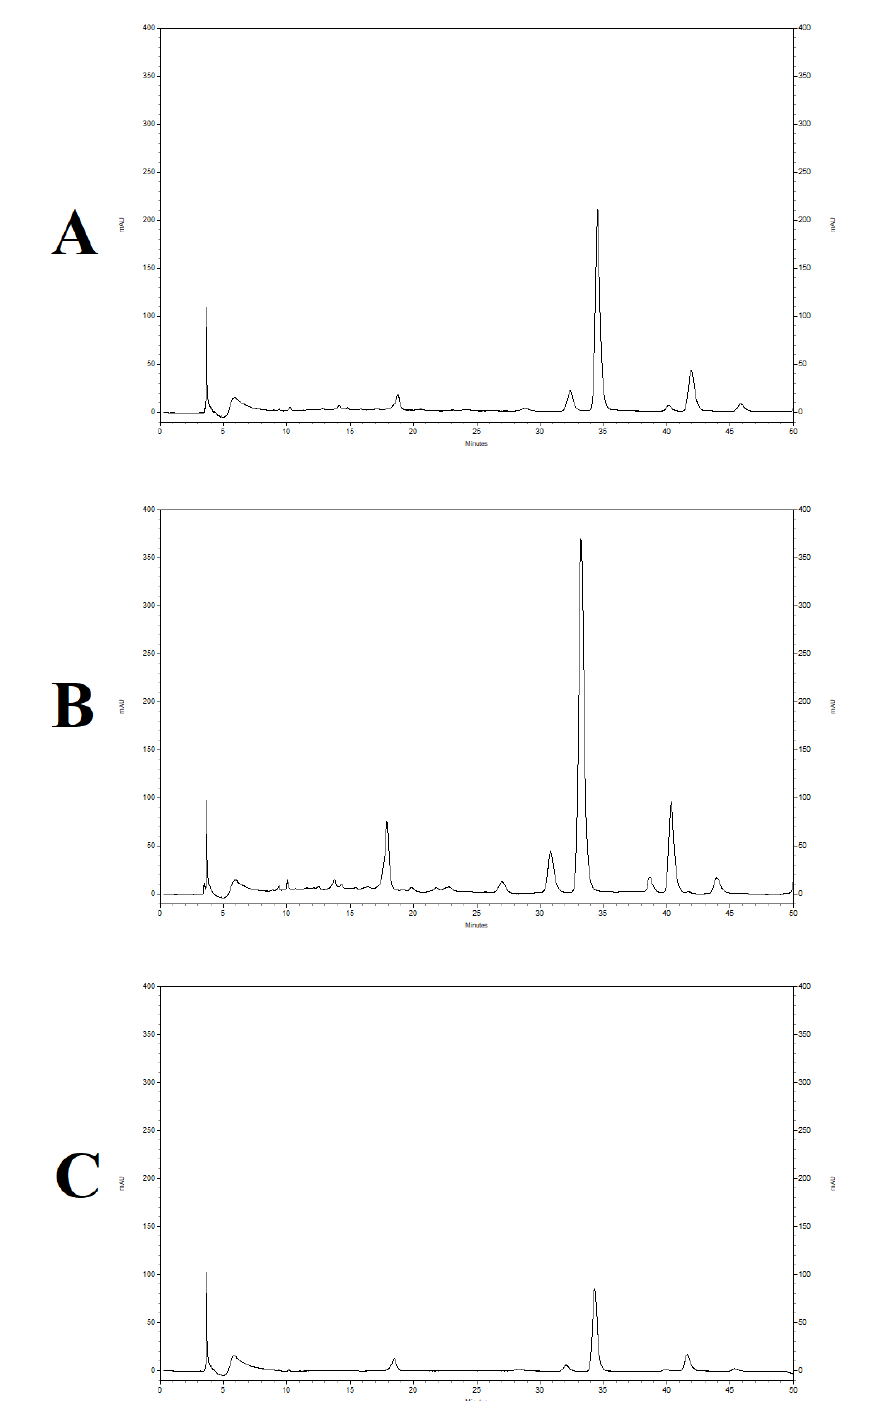
FIGURE 3 - HPLC chromatogram of astilbin using 300 W of microwave power and six cycles of microwave-assisted extraction in different solvents: (A) ethanol, (B) water:methanol (40:60), and (C) ethyl